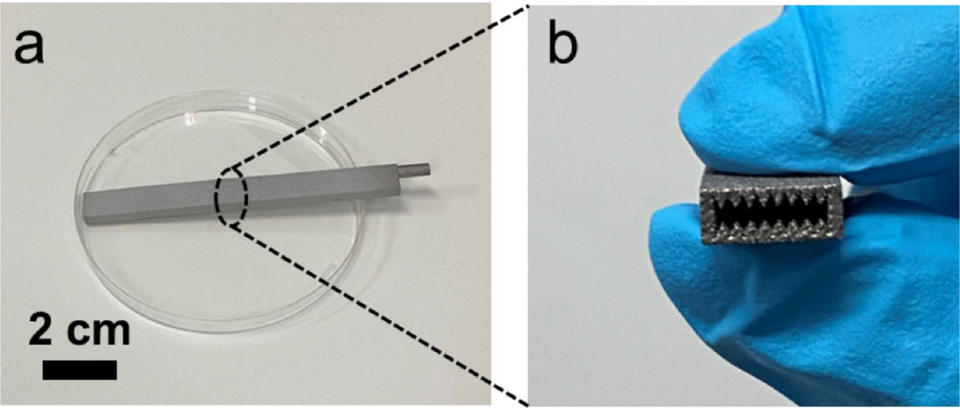
Figure 5. The photo of the flat miniature HP with microgrooves: ( a ) image of the AM flat HP; ( b ) cross-section of the AM flat HP [35].